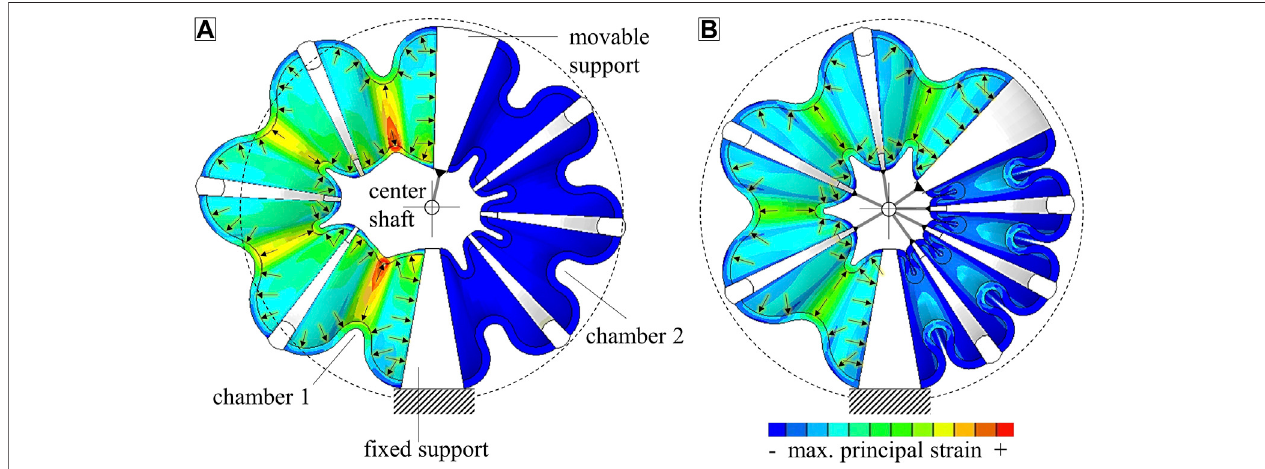
FIGURE 1 | Schematics and typical strain distributions in rotary bellows actuators without (A) and with (B) constrained motion of the elastomeric bellows chambers. Applying a pressure difference between chambers 1 and 2 causes the bellows actuator to rotate. Constraining the radial displacement of the bellows structure (B) improves performance, inhibits excessive deformation and results in more homogeneous distribution of strain than in an unconstrained design (A) .